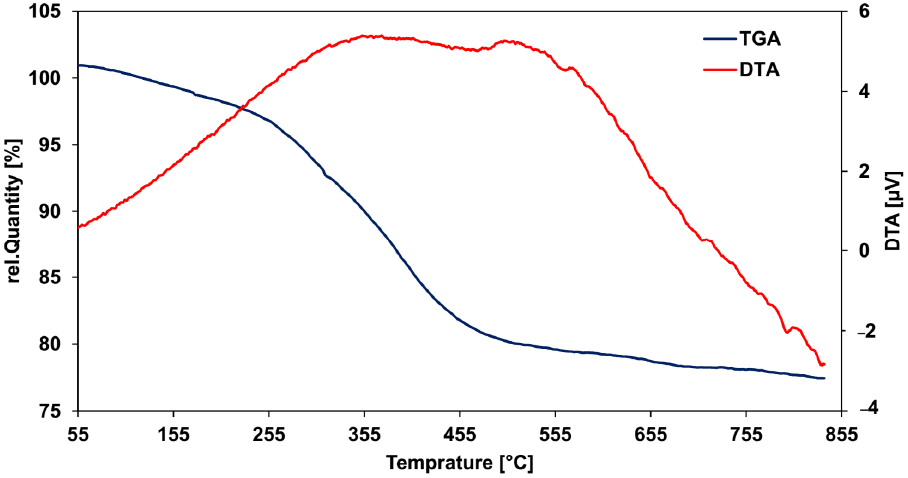
Figure 7. The TG/DTA pattern of biosynthesized CC-AuNPs.